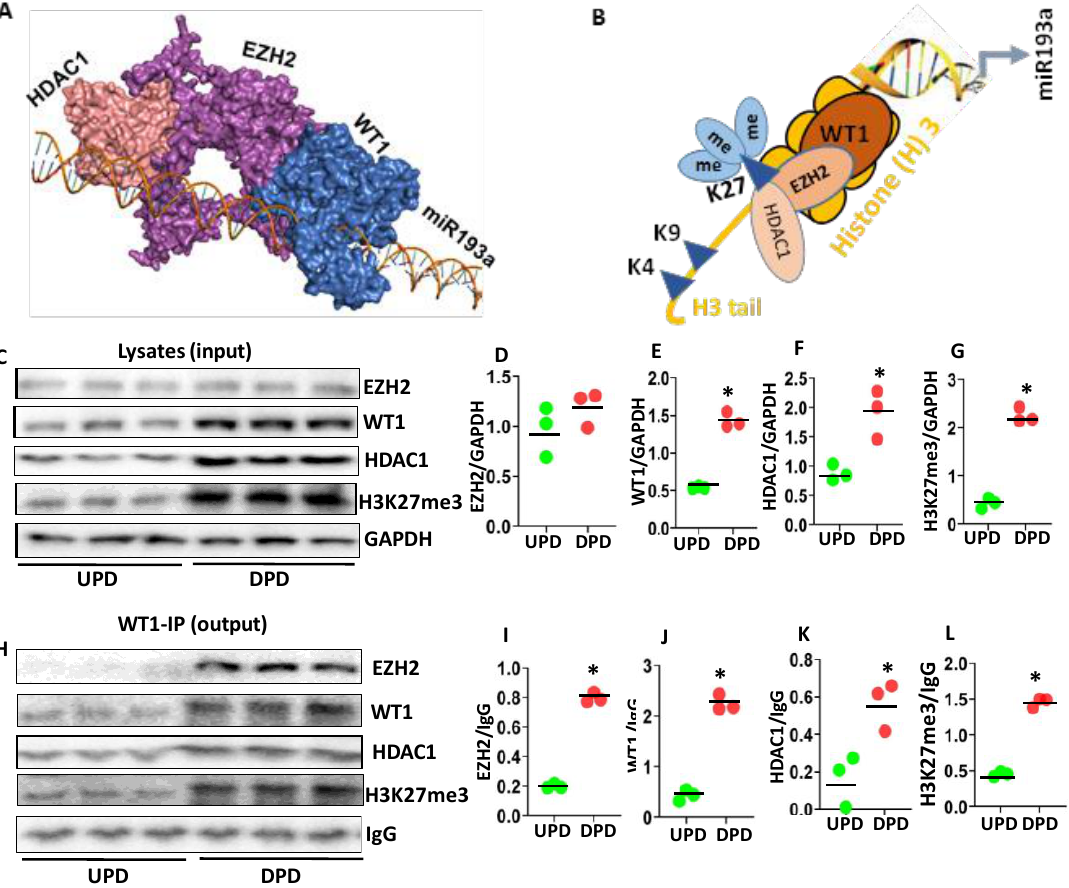
Figure 6. Analysis of the WT1-EZH2 repressor complex. ( A ) The structural construct of the WT1-EZH2 repressor complex. ( B ) A schematic diagram is displaying the formation of the WT1 repressor complex at the miR193a promoter. WT1 recruits EZH2, SMRT, and HDAC1 inducing methylation at lysine 27 residues at Histone (H) 3 tail. ( C ) Protein blots of three di ff erent cellular lysates of UPDs and DPDs were probed for WT1, EZH2, HDAC1, and H3K27me3, and GAPDH. Gels of three independent lysates are shown. ( D – G ). Cumulative densitometric data (protein / GAPDH) are shown as dot plots. * p < 0.05 compared with respective UPD. ( H ) Cellular lysates from protocol C were immunoprecipitated (IP) with the WT1 antibody. Protein blots of WT1-IP fractions were probed for WT1, EZH2, HDAC1, and H3K27me3, and IgG. Gels are displayed. ( I – L ) Cumulative densitometric data (protein / GAPDH) from the protocol H, are shown as dot plots. * p < 0.05 compared with respective UPD. We proposed that WT1 binds with the miR193a promoter and recruits the methyltransferase EZH2 along with HDAC1 resulting methylation of K27 at Histone (H) 3 tail, as shown in the schematic diagram